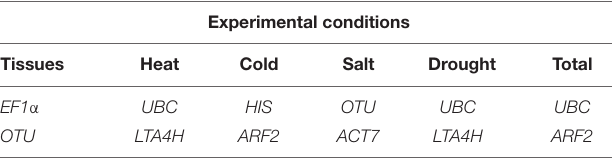
TABLE 6 | Best combination of RGs based on the geNorm and RankAggreg